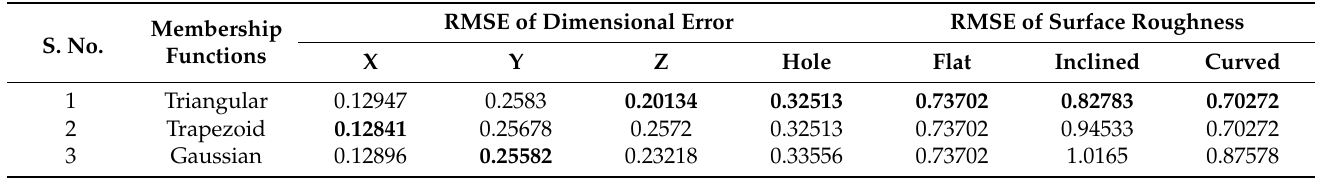
Table 5. Average testing error for output responses with different membership